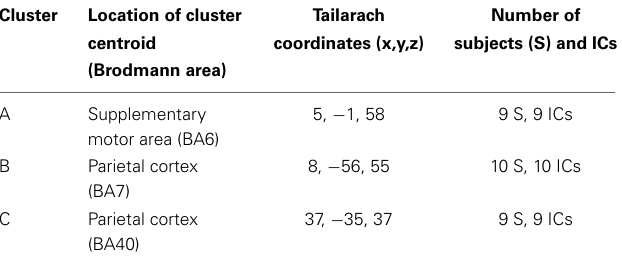
Table 1 | Clusters of independent sources obtained with ICA.